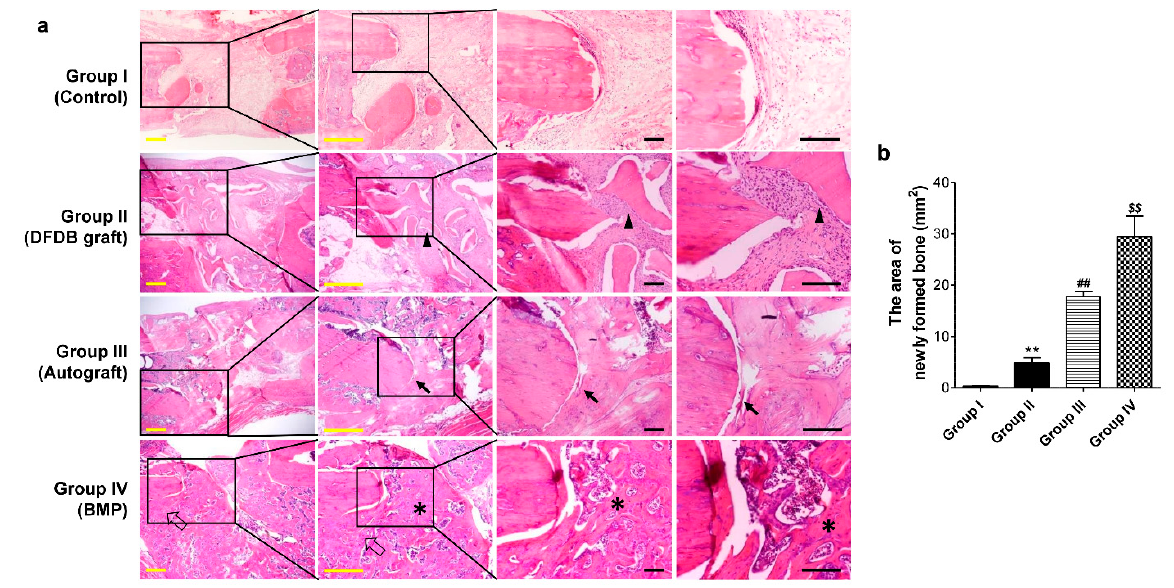
Figure 5. Histologic findings of the bone defect sites in the various experimental groups. ( a ) The bone defect site was filled with fibrous tissue without bone formation in the absorbable collagen sponge alone group. The defect site in the demineralized freeze-dried bone (DFDB) graft group was filled with fragmented lamellar bone (the arrowhead indicates the grafted bone) and fibrous tissue. The defect site in the autograft group was also filled with lamellar bone. However, the lamellar bone in the defect site with an autograft was thicker and more abundant, with relatively less fibrous tissue compared to the DFDB graft group. However, the junction between the cortical bone and newly formed bone from the autograft was partially discontinuous (arrows). In contrast, the defect site in the BMP-treated group was filled with newly formed bone (asterisks), and the junction between the cortical bone and new bone was continuous (empty arrows). Yellow bars = 1 mm, Black bars = 200 µm. ( b ) The measurement of the area of newly formed bone from staining images of tissue sections (n = 10), and the values are means ± SEM. and the values are means ± SEM. ** p < 0.01 versus group I, ## p < 0.01 versus group II, $$ p < 0.01 versus group III.